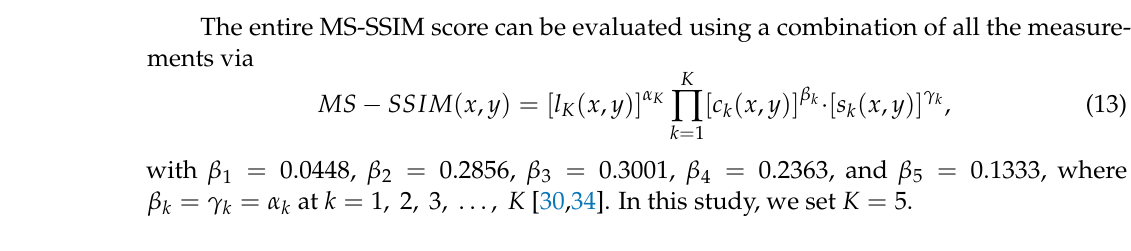
Figure 3. MS-SSIM diagram to demonstrate the measurement procedure. L denotes low-pass filtering and 2 ↓ refers to down-sampling by